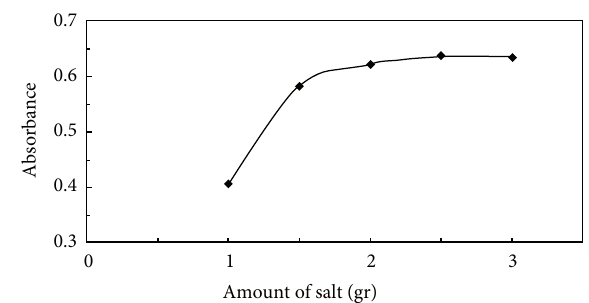
F 4: Effect of amount of PEG 4000 on the extraction efficiency. Experimental conditions: volume of buffer; 9mL, pH of sample; 5.5, amountofsodiumcarbonate;2.5gr,temperature;35 time; 10min, 4ng/mL of brilliant blue.